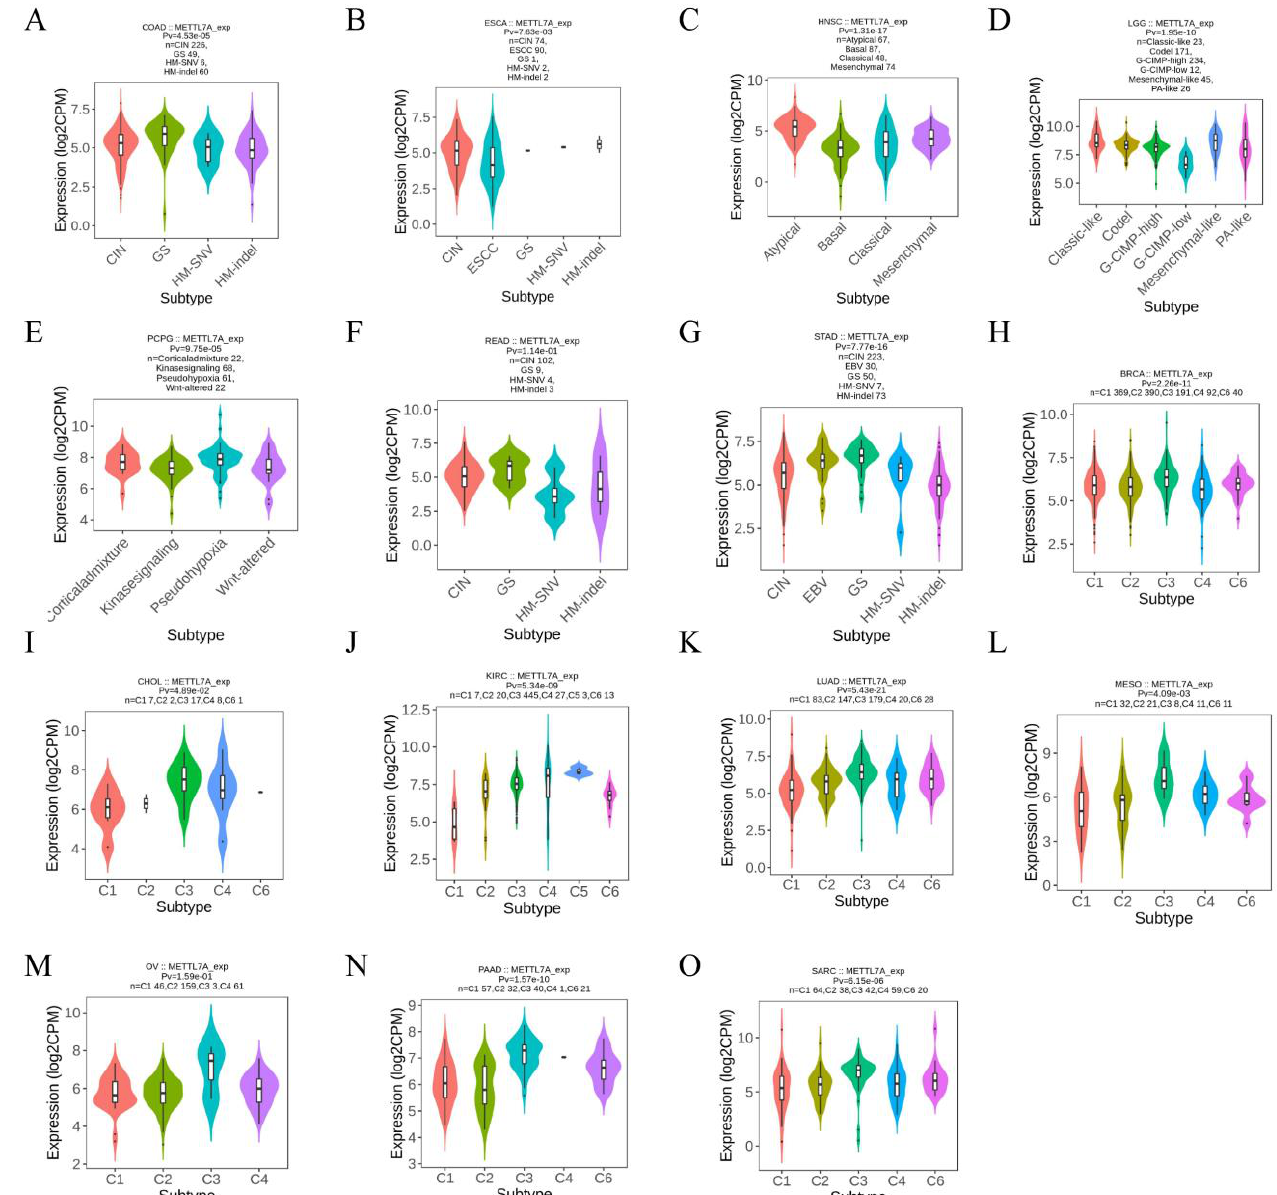
Figure 3. Correlation between METTL7A expression and molecular or immune subtypes across TCGA tumors. A – G : molecular subtypes. ( A ) colon adenocarcinoma (COAD); ( B ) esophageal carcinoma (ESCA); ( C ) head and neck squamous cell carcinoma (HNSC); ( D ) brain lower grade glioma (LGG); ( E ) pheochromocytoma and paraganglioma (PCPG); ( F ) rectum adenocarcinoma (READ); ( G ) stomach adenocarcinoma (STAD). H – O : immune subtypes. ( H ) breast invasive carcinoma (BRCA); ( I ) cholangiocarcinoma (CHOL); ( J ) kidney renal clear cell carcinoma (KIRC); ( K ) lung adenocarcinoma (LUAD); ( L ) mesothelioma (MESO); ( M ) ovarian serous cystadenocarcinoma (OV); ( N ) pancreatic adenocarcinoma (PAAD); ( O ) sarcoma (SARC). C1: wound healing, C2: IFN-gamma dominant, C3: inflammatory, C4: lymphocyte depleted, C5: immunologically quiet, C6: TGF-b dominant.